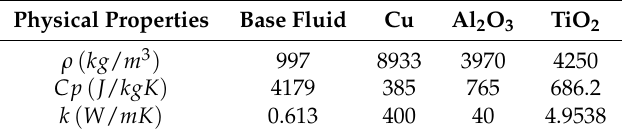
Table 1. Thermophysical properties of base fluid and nanoparticles [29,30].